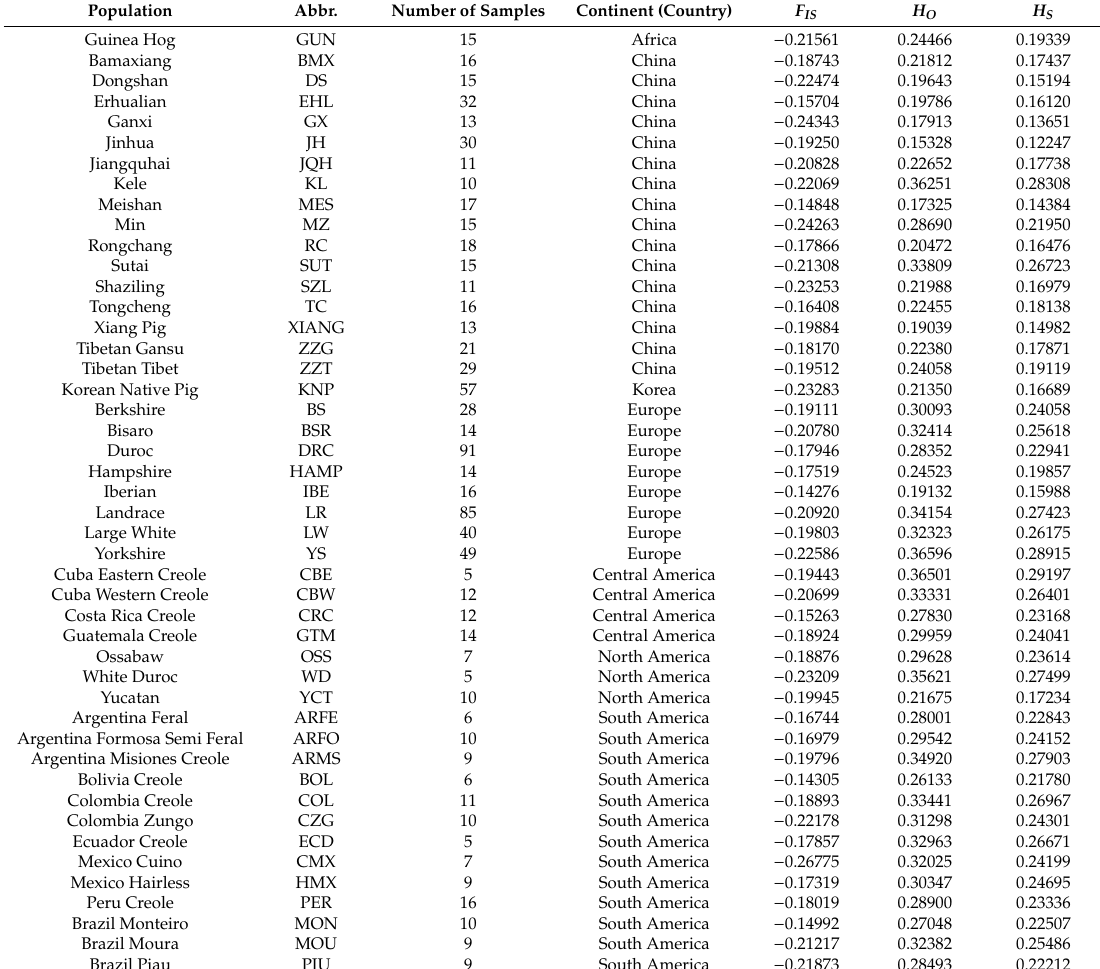
Table 1. Characteristics of the pigs used in this study, stratified by